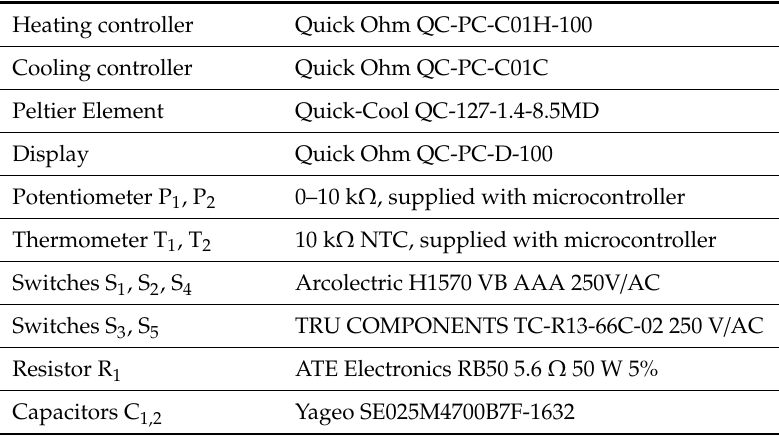
Figure S1: Illustration to describe the definition of the gating potential in T cells. Voltage ramp from − 65 mV to + 15 mV (black). Position / potential of the increase (red dashed) in the membrane current (blue), Table S1: Statistical analysis of patch clamp results via ANOVA with post hoc Turkey’s